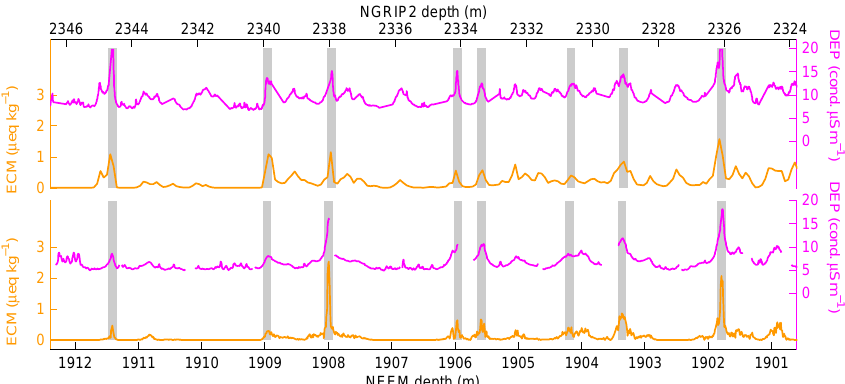
Fig. 3. Example of ECM and DEP data across a synchronized section of the NEEM and NGRIP cores. The grey bands mark the match points used for the timescale transfer.